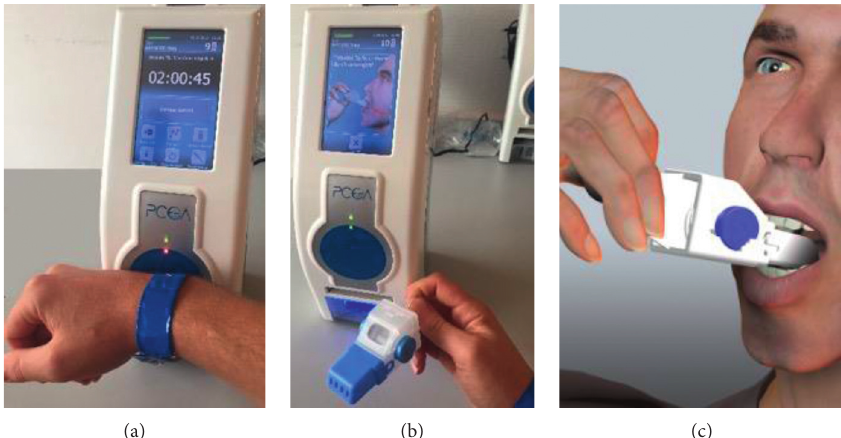
Figure 1: PCoA ® Acute: the device is set up and positioned near the patient’s bedside. (a) Patient identity is confirmed by registration of the RFID wristband. (b) The patient withdraws the pillbox to take a pill. (c) The patient applies light suction on the pillbox mouthpiece to receive a